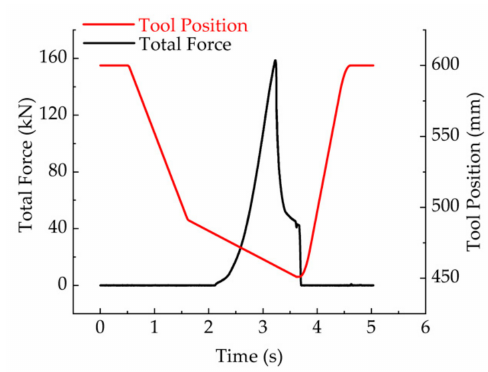
Figure 3. Displacement by time and force by time during an exemplary deep drawing experimental